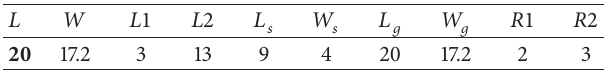
Table 1: Optimized antenna parameter (mm).